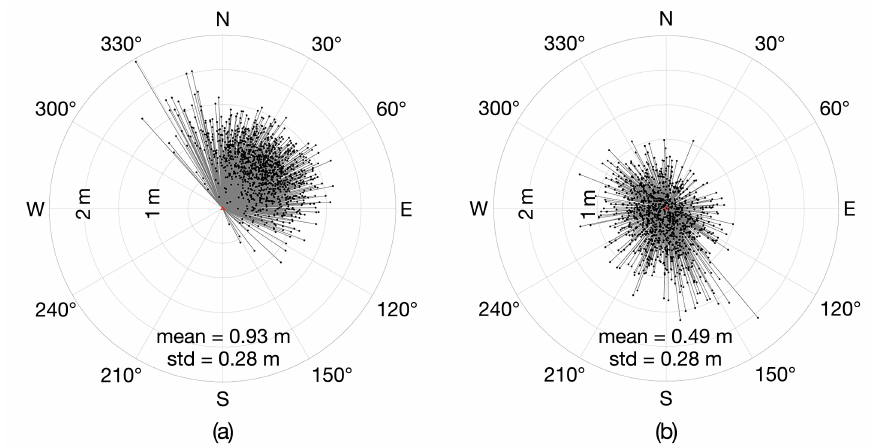
Figure 7. Single-point ( a ) and kinematic instantaneous ( b ) horizontal position error.